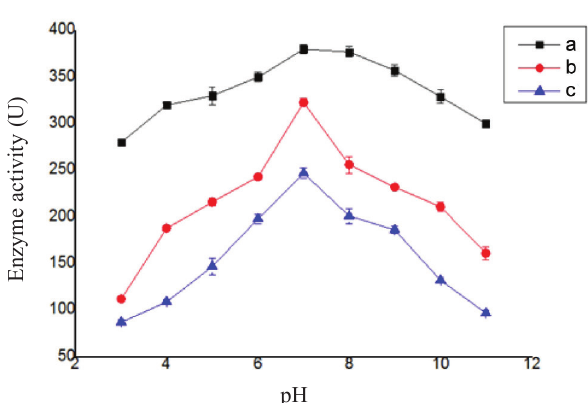
Fig. 6 – Effect of pH on enzyme activity: a) enzyme activity under different pH; b) residual enzyme activity after 1 h; c) residual enzyme activity after 2